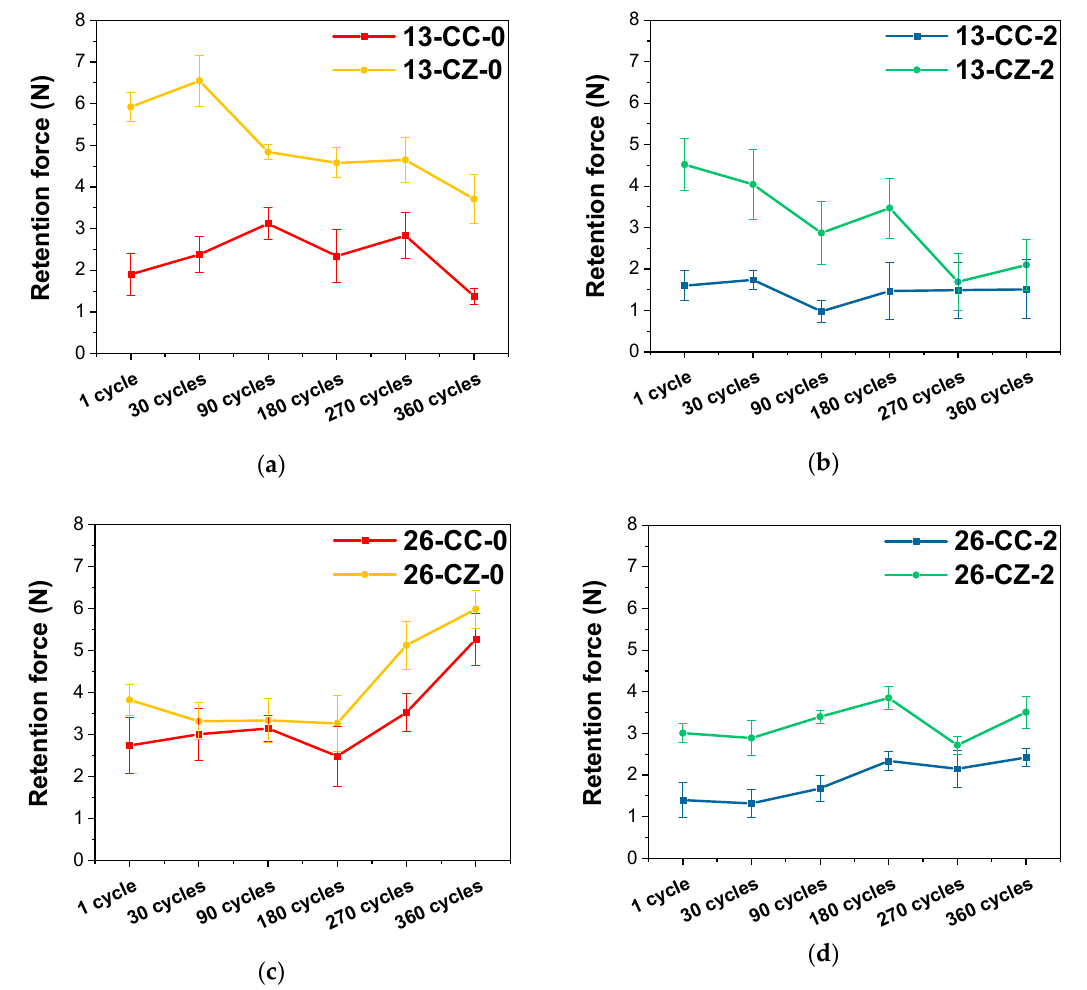
Figure 6. Evolution of the retention forces as a function of the materials used for manufacturing the telescopic system. ( a ) tooth 1.3—taper angle 0°; ( b ) tooth 1.3—taper angle 2°; ( c ) tooth 2.6—taper angle 0° and ( d ) tooth 2.6—taper angle 2°.